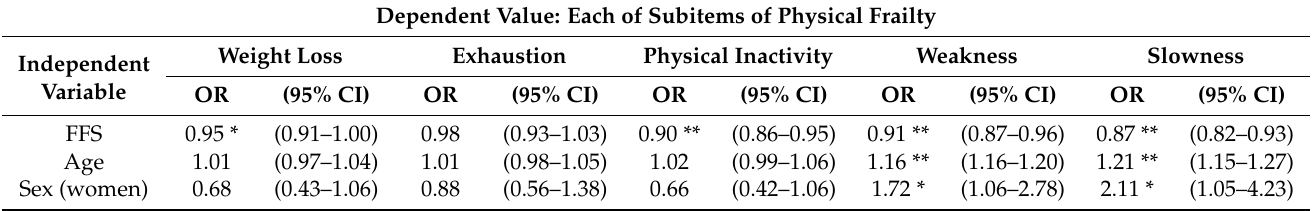
Table 3. Association between food frequency score and sub-items of physical frailty. Dependent Value: Each of Subitems of Physical